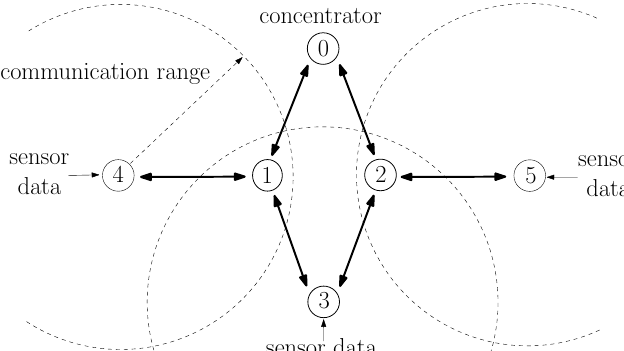
Figure 1. ZigBee network in which sensor data at nodes 3, 4, and 5 are transmitted to a concentrator at node 0 using nodes 1 and 2 as